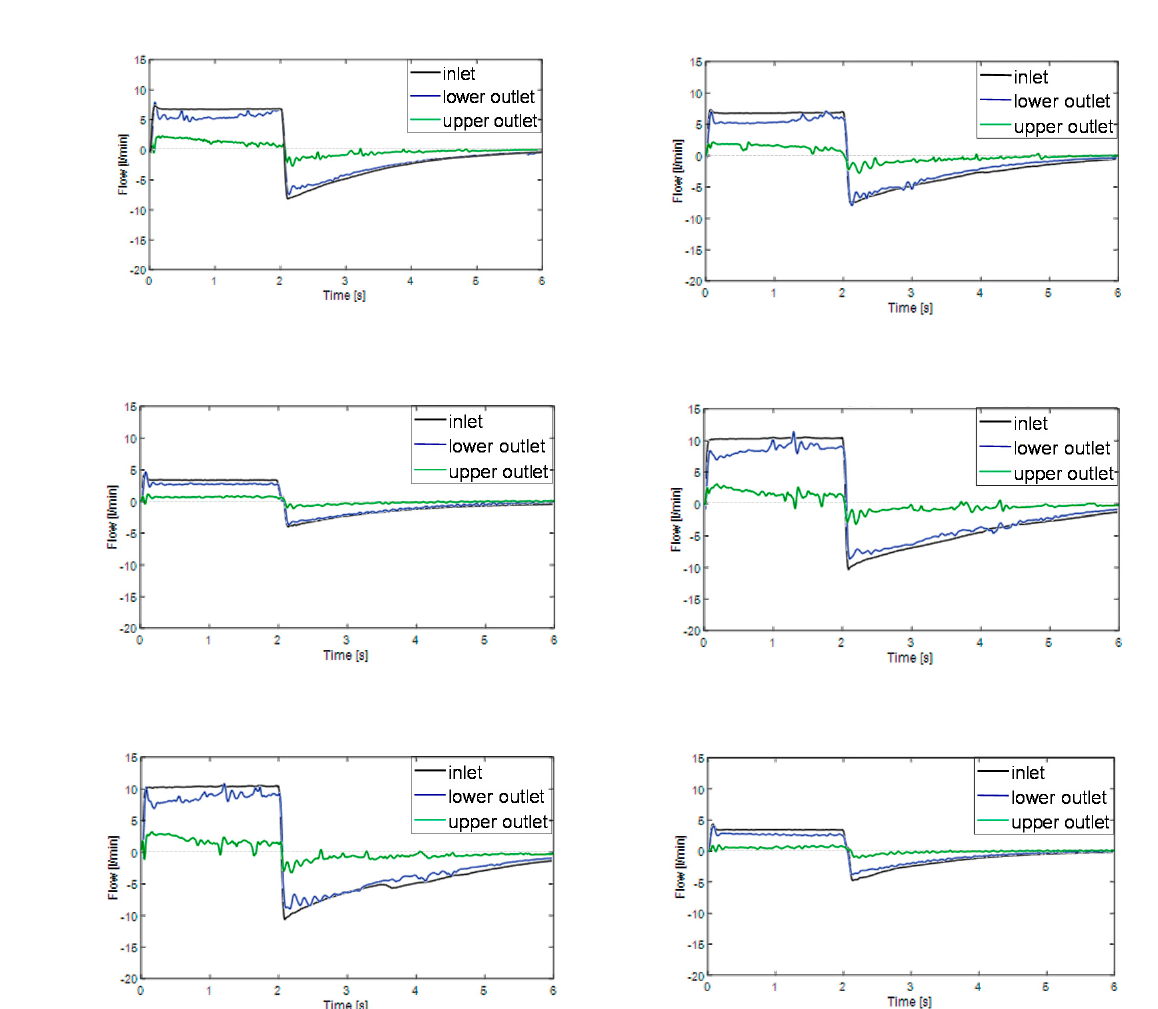
Figure 6. Flow-time relationships during breath cycle for model lungs with high compliance (ca. 200 mL/cm H 2 O) for various tidal volume divisions (lower outlet—branch with higher compliance; upper outlet—branch with lower compliance). Time 0–2 s represents inspiration phase, time 2–6 s represents expiration phase.